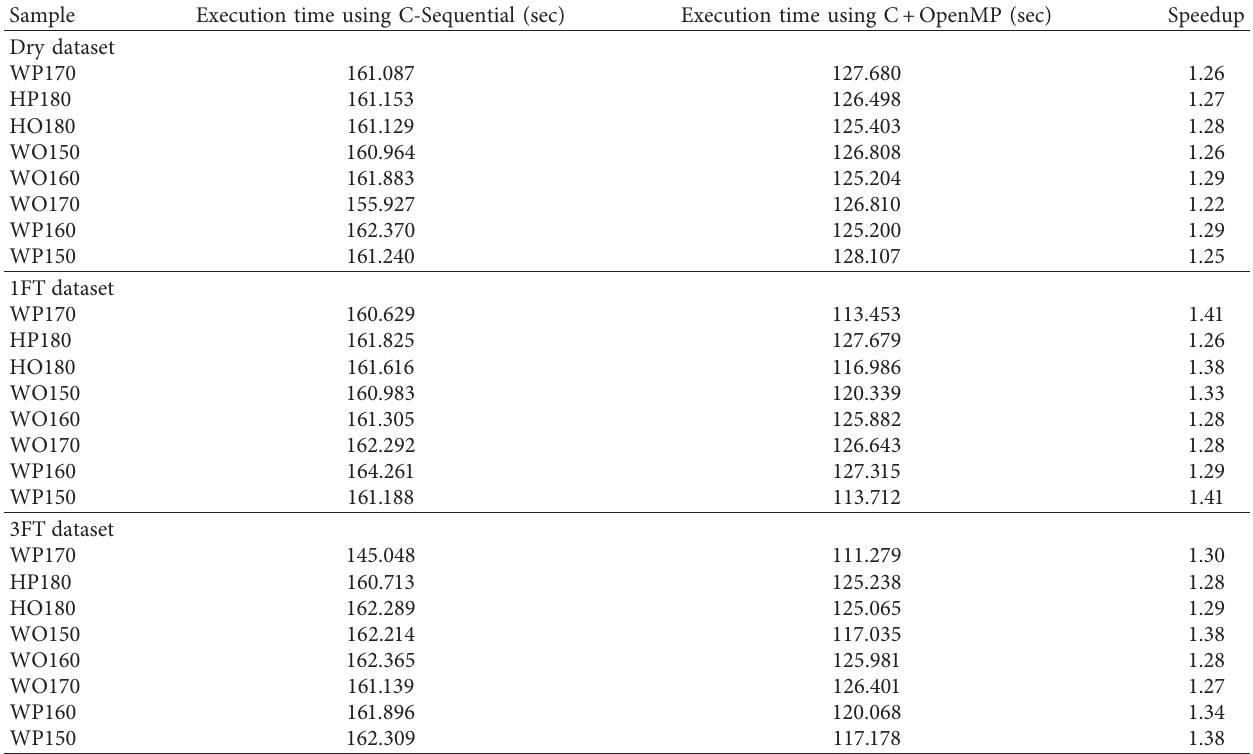
Table 9: Computation of speedup ( k � 10).